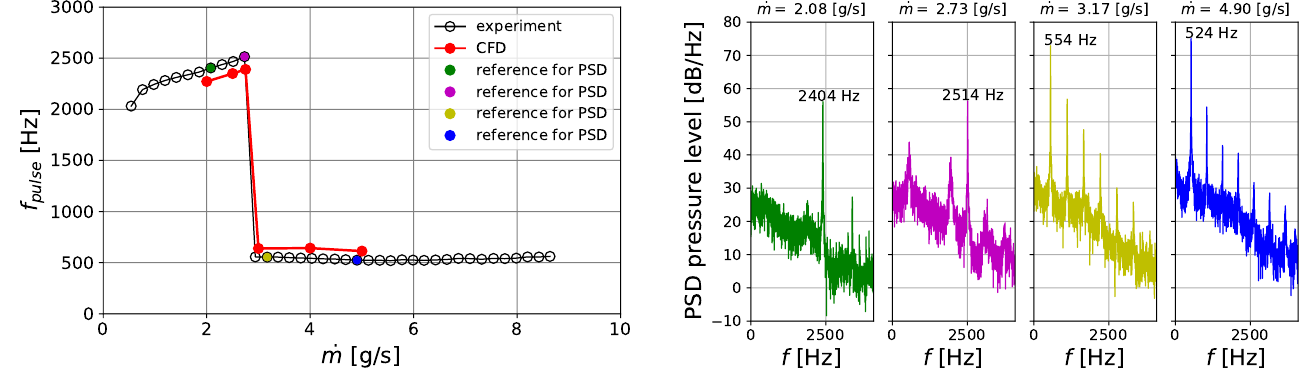
Figure 11. Comparison of experimental and numerical results of FO-PJA frequency response with increasing mass flow rate ( left ) and corresponding PSD of most important points ( right